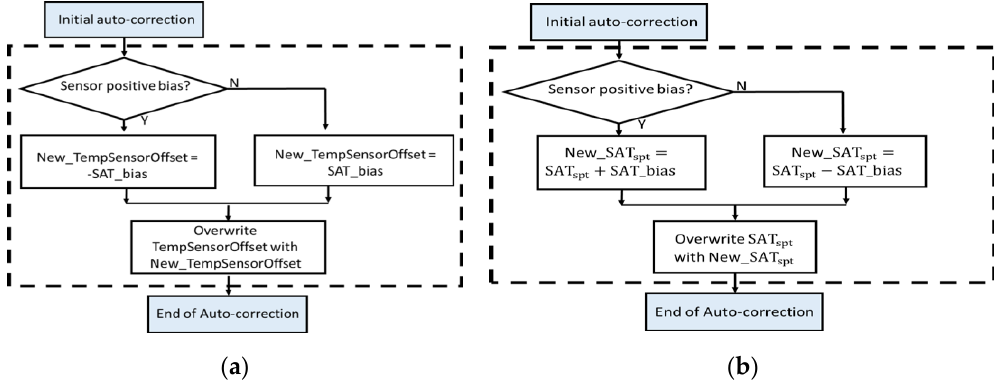
Figure 3. Flowchart of the supply ai temperature (SAT) sensor bias fault auto-correction algorithm.